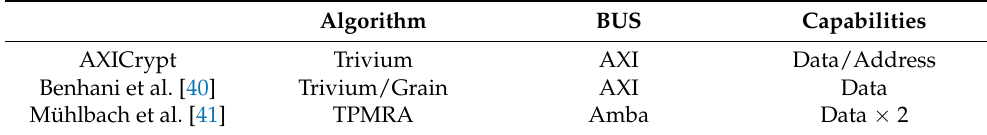
Table 2. Comparison of capabilities.